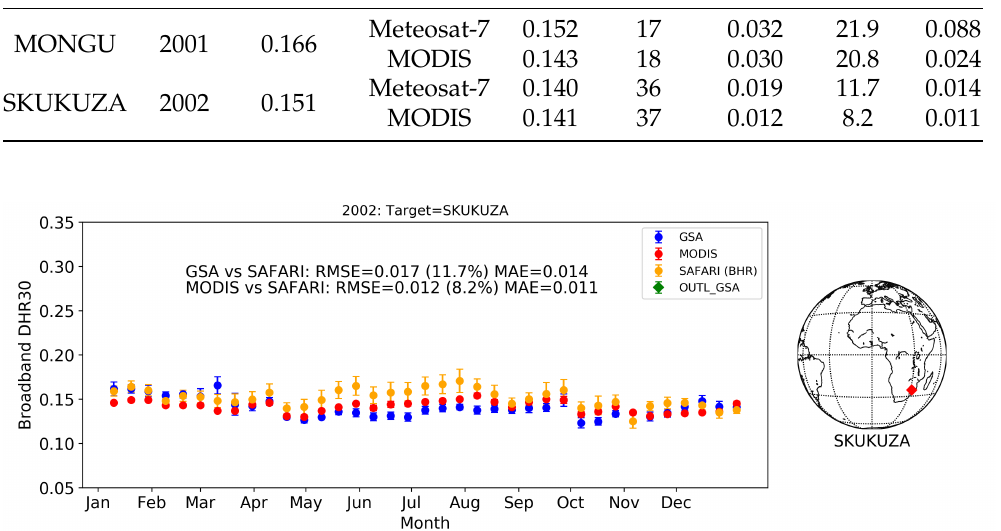
Figure 9. Comparison between GSA (Meteosat-7), MODIS and SAFARI for the year 2002 for the site SKUKUZA. GSA and MODIS are expressed as black-sky albedo (DHR30), while SAFARI is represented as blue-sky albedo (BHR). One GSA retrieval has been flagged as